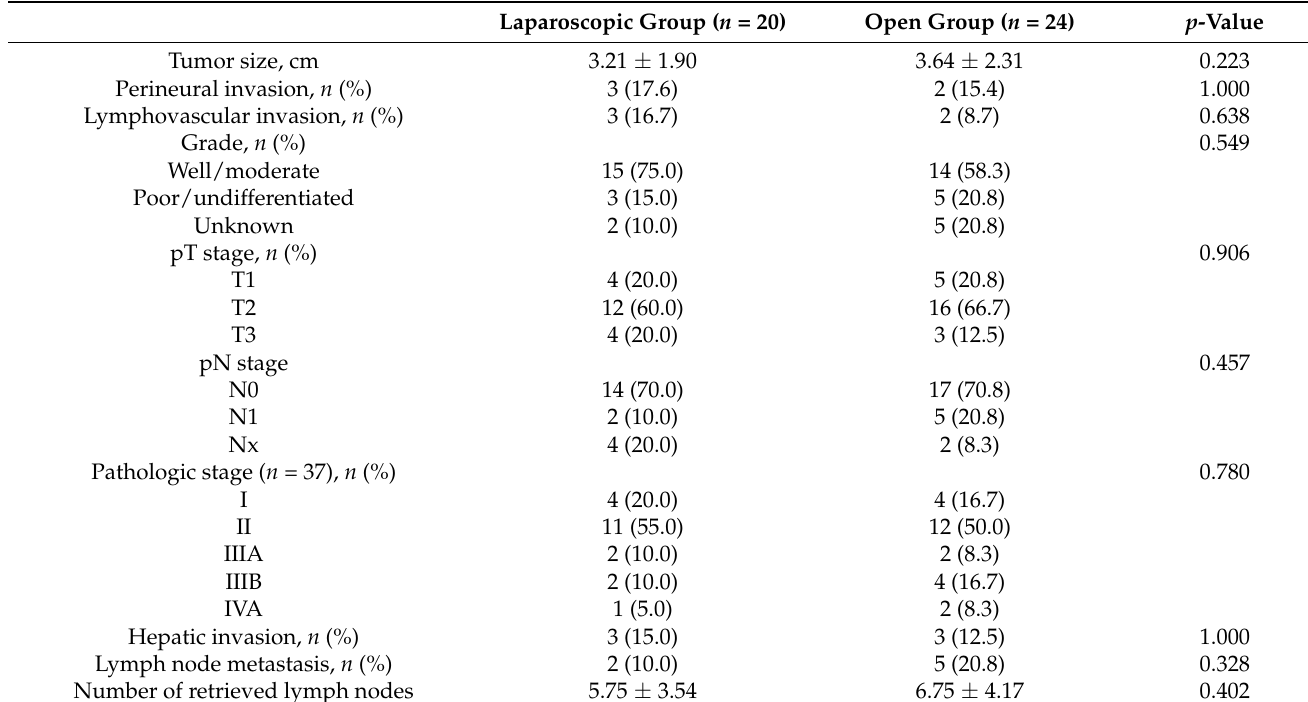
Table 3. Comparison of histopathologic outcomes in laparoscopic and open group.